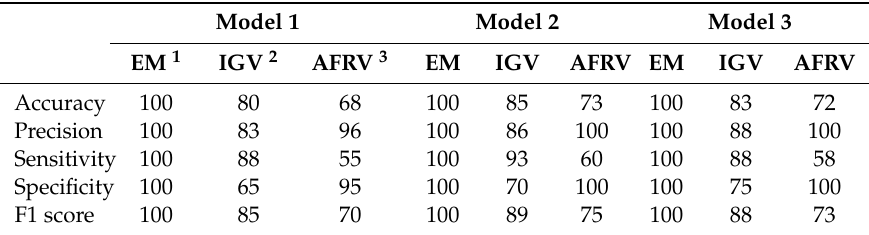
Table 8. Model evaluation metrics (%).